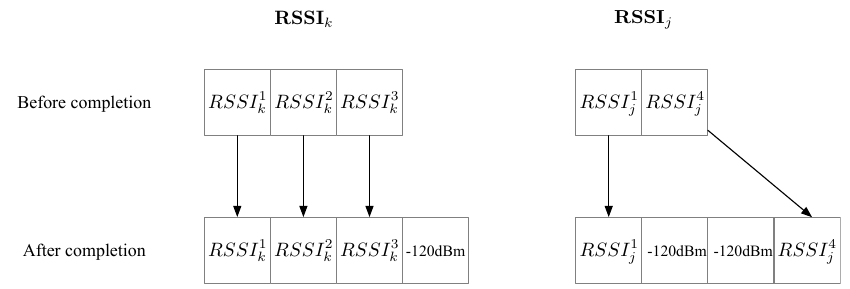
Figure 6. An example for the RSSI completion process before calculation of the RSSI